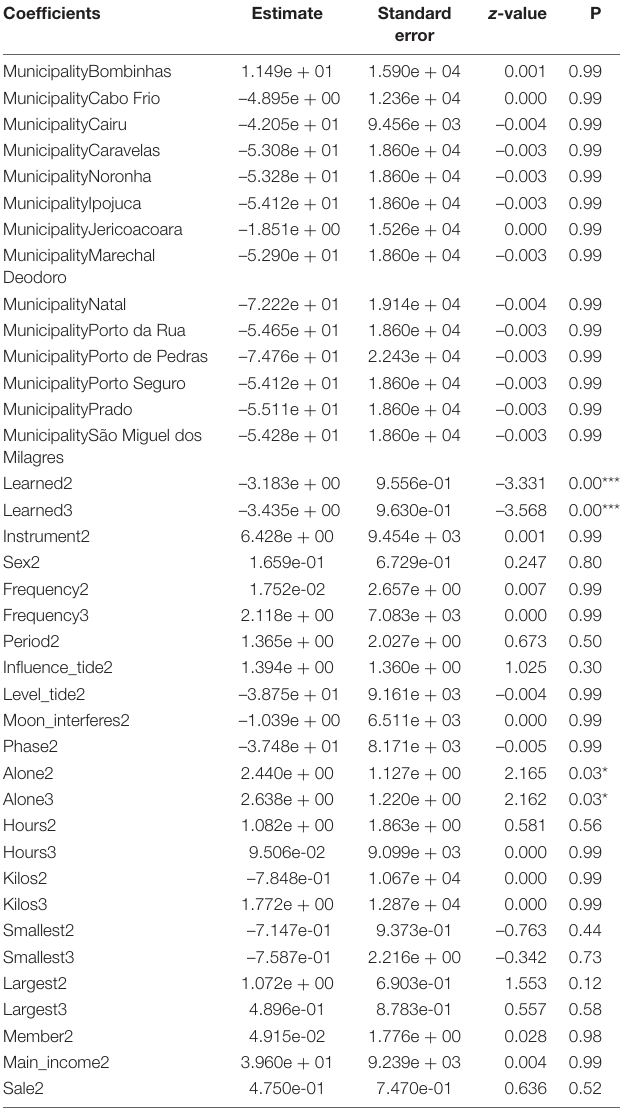
TABLE 3 | Result of the logistic regression model with the variables that may be associated with fishing of the “eastern Octopus” ( C. furvus ).